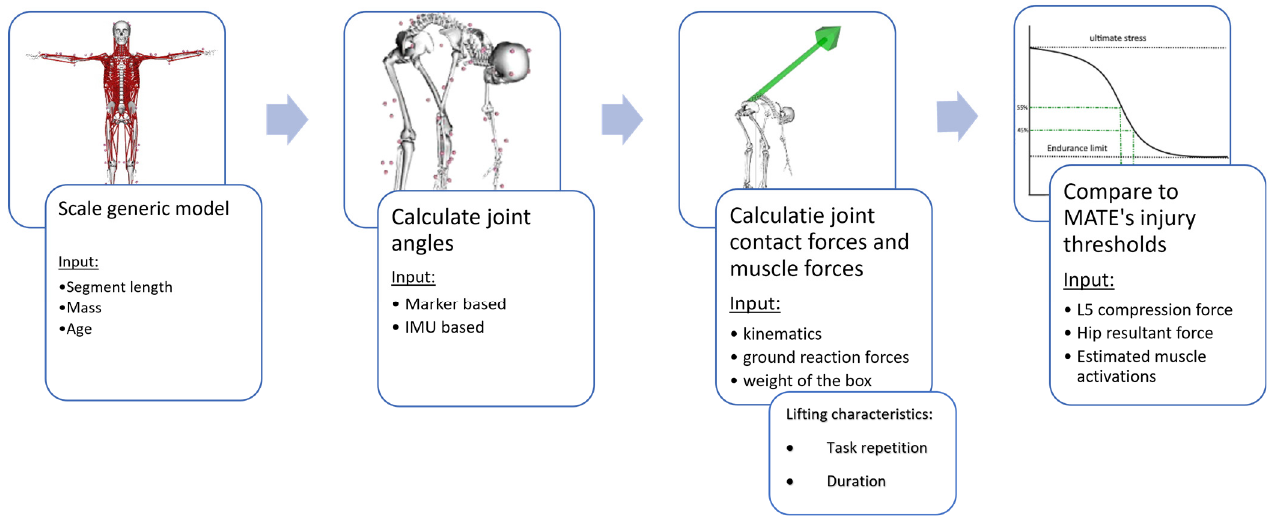
Figure 2. General overview of the MATE